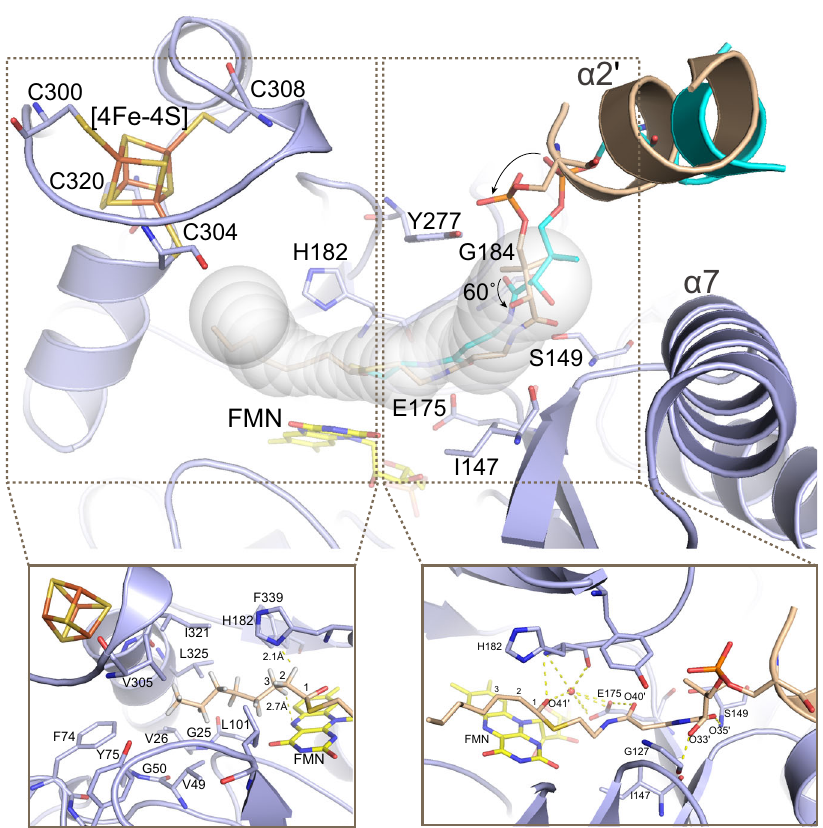
Fig. 4 The interactions of the octanoyl chain carried by the PPant prosthetic group of ACP inside the FabX tunnel. Structural superposition of FabX – holo-ACP complex (green/cyan, only ACP was shown) with FabX – octanoyl-ACP complex (light blue/wheat). Residues involved in the interactions were shown in sticks and labeled. The active site tunnel is shown as a transparent white tube. Yellow dashes indicate hydrogen bonds between FabX residues and the acyl chain or PPant